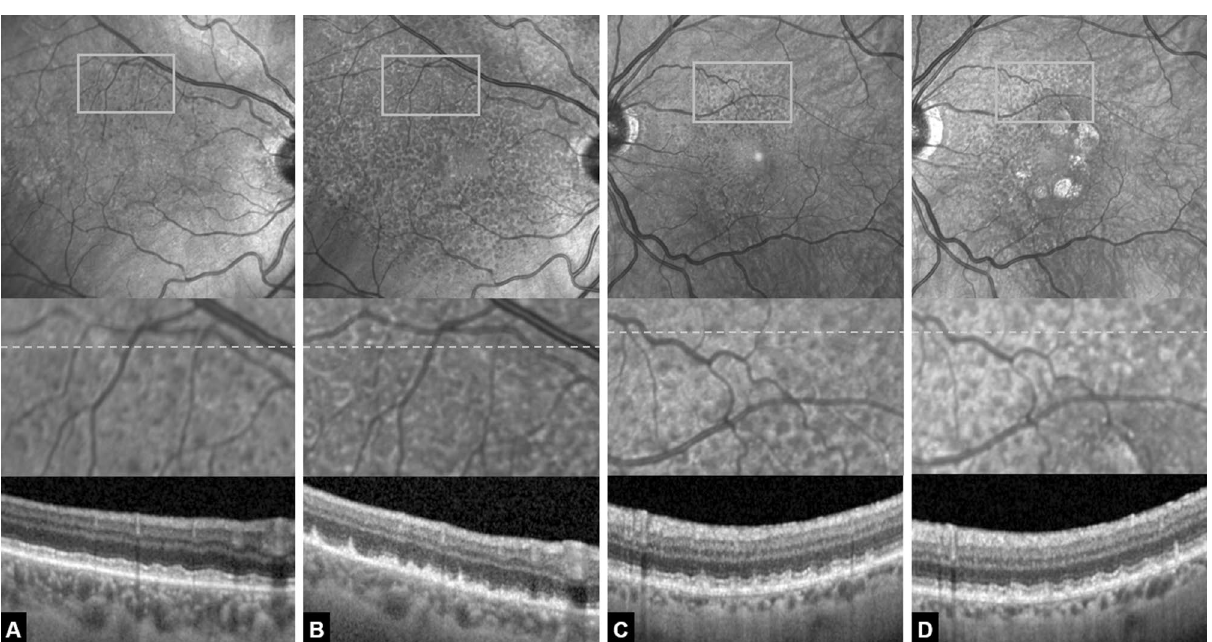
Figure 2. ( A , B ) Example of a 70-year-old female reticular pseudodrusen (RPD) patient that developed a significant increase in RPD-affected area over the 5-year follow-up yet no late-stage form of age-related macular degeneration. ( A ) Baseline. Above near-infrared confocal scanning laser ophthalmoscopy (cSLO) image showing hyporeflective dots superiorly located to the fovea. Rectangle marks the area magnified below. Grey dotted line marks the location of the optical coherence tomography (OCT) scan below. ( B ) Same eye after 5 years. Note the increase in RPD-affected area and the increase in lesion density visible both in the cSLO en-face image above as well as in the magnified image. The OCT scans reveal early RPD stages at baseline and predominantly stage-three RPD lesions at 5-year follow-up. Also note signs of incomplete outer retinal atrophy in ( B ). There is detritus on the intact RPE monolayer with remnants of the ellipsoid zone but no hypertransmission. Individual RPD lesions are harder to discern. ( C , D ) Example of a 71-year-old female RPD patient that developed geographic atrophy over the 5-year follow-up. ( C ) Baseline. ( D ) Same eye after 5 years. Note the perifoveal patches of geographic atrophy and a moderate increase in RPD-affected area and lesion density. The OCT scan appears rather similar to the baseline image without any signs of outer retinal